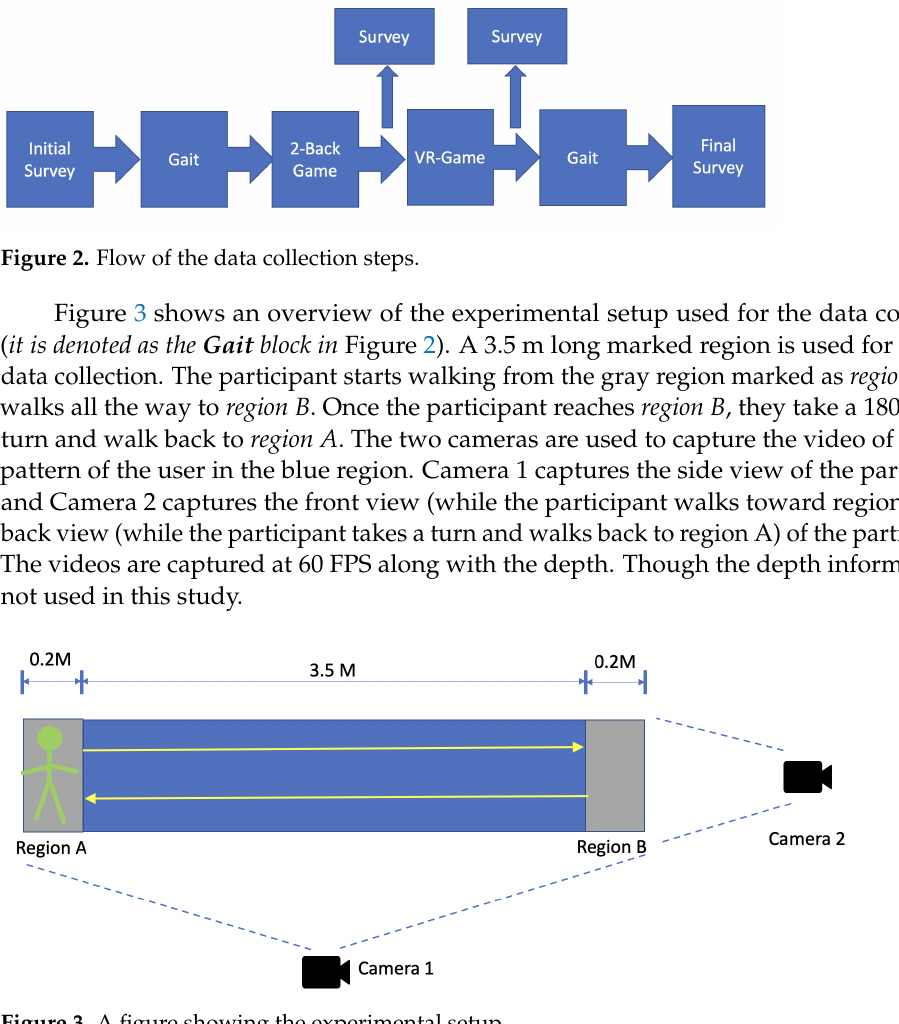
Figure 3. A figure showing the experimental